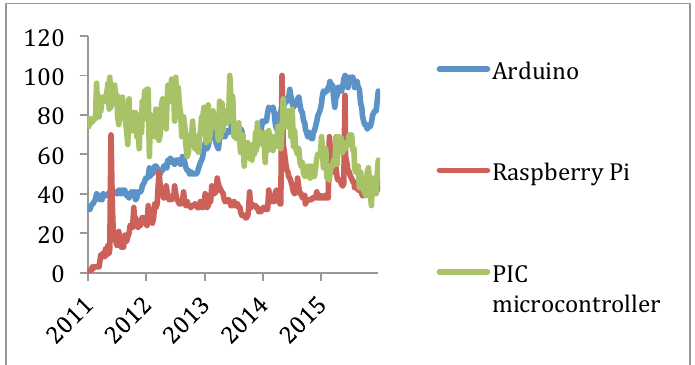
Fig. 2. Google trends extracted history of searches for the past 5 years.